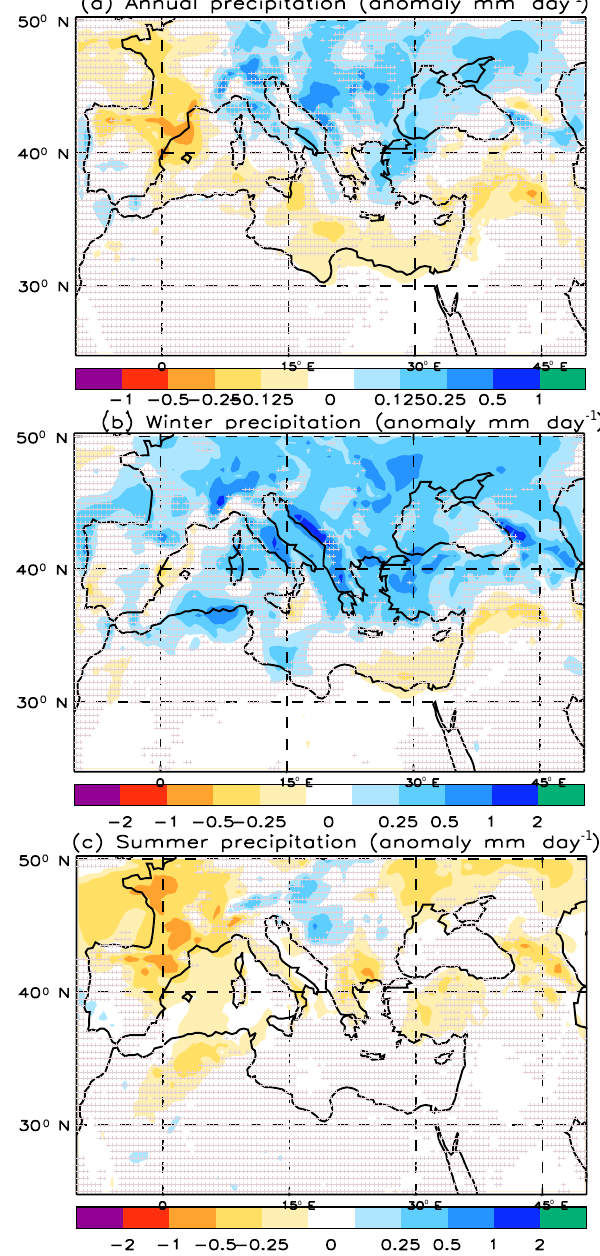
Figure 4. Model simulation showing present day minus preindus- trial precipitation anomalies (hatching at 70% statistical signifi- cance over the insignificant